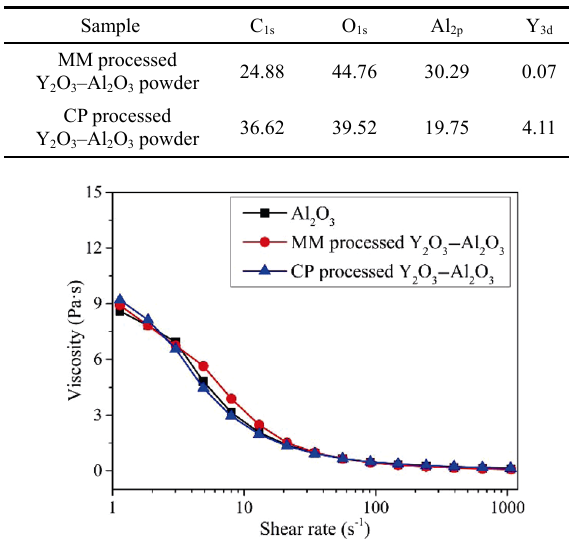
Fig. 5 Viscosities of 20 vol% Al 2 O 3 and Y 2 O 3 –Al 2 O 3 ceramic suspensions.